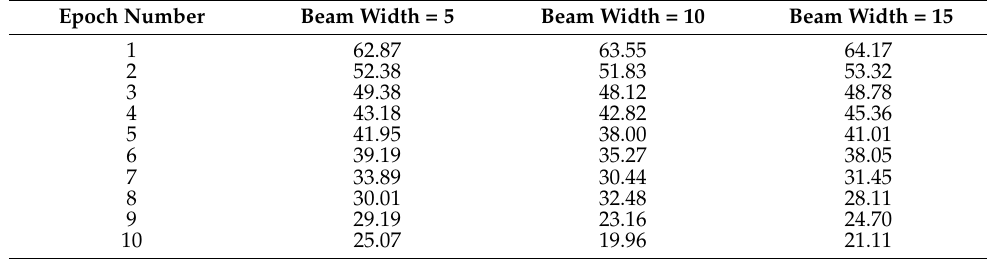
Table 6. Sensitivity analysis results for beam width (loss value).